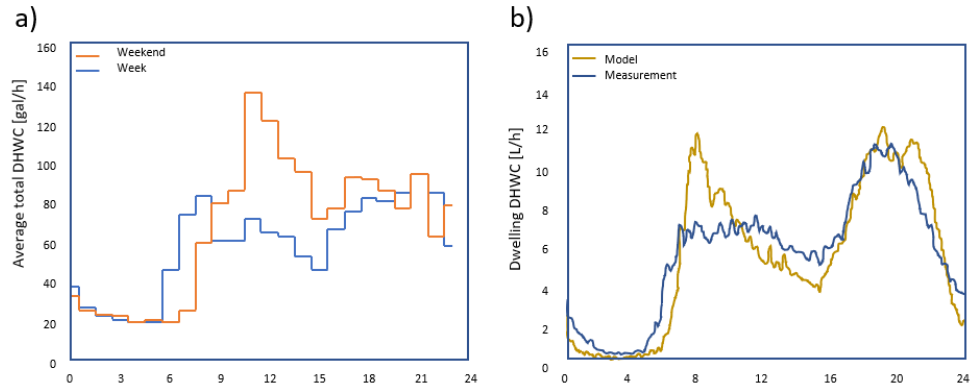
Figure 4. Hourly DHWC profiles adapted from ( a ) Vine et al. [15]. Reprinted/adapted from Ref. [15], Copyright 1987, with permission from Elsevier and ( b ) Rouleau et al. [16]. Reprinted/adapted from Ref. [16], Copyright 2019, with permission from Elsevier.